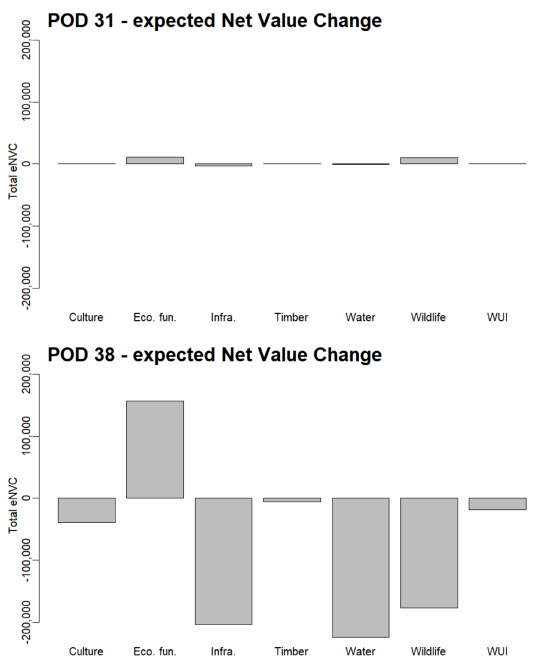
Figure 9. Risk assessment profiles for POD 31 (top) and POD 38 (bottom), breaking down total expected net value change (eNVC; Figure 4) into individual eNVC scores for seven categories of highly valued resources and assets (cultural resources, ecosystem function, infrastructure, timber resources, water, wildlife, and wildland–urban